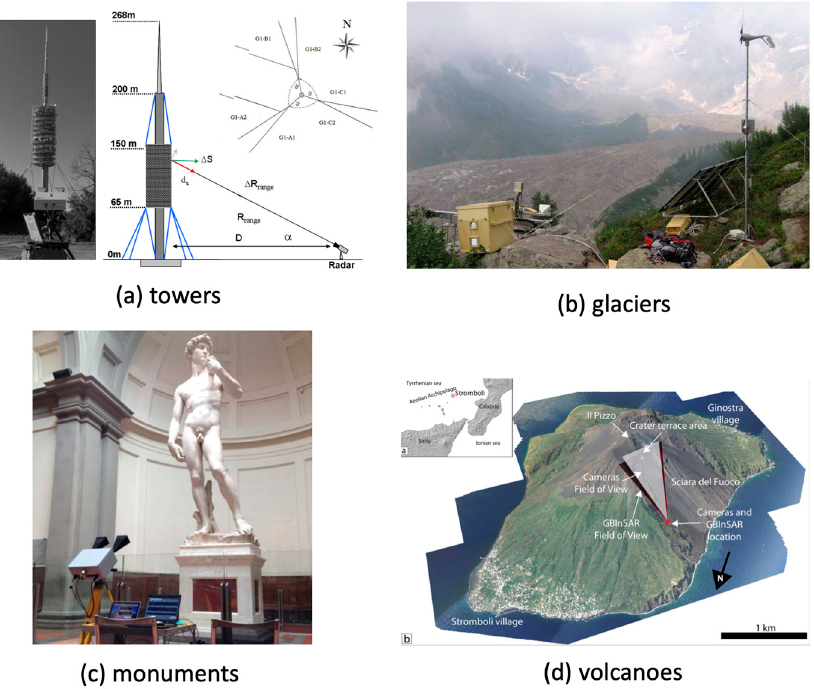
Figure 10. Examples of GBRI applications: ( a ) towers (after [64]); ( b ) glaciers (after [65]); ( c ) monuments (after [25]); (d) volcanoes, permanent installation at the Stromboli volcano, Italy (after